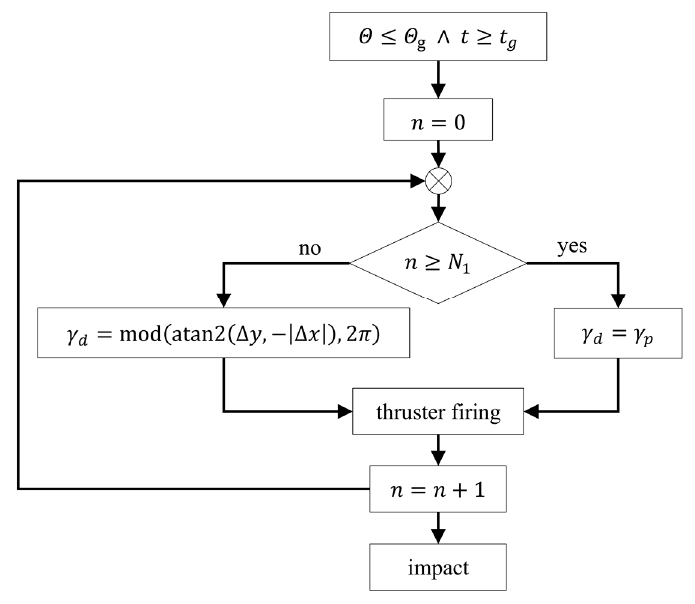
Figure 5. Guidance process with the trajectory shaping Figure 5 . Guidance process with the trajectory shaping functionality.